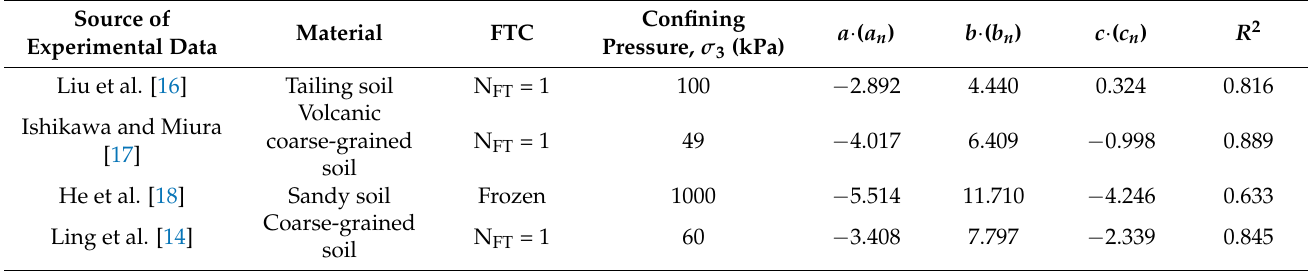
Figure 4. Fitting curves of ( a ) empirical constant a ; ( b ) empirical constant b ; and ( c ) empirical constant d . Table 3. Values of the parameters of the prediction